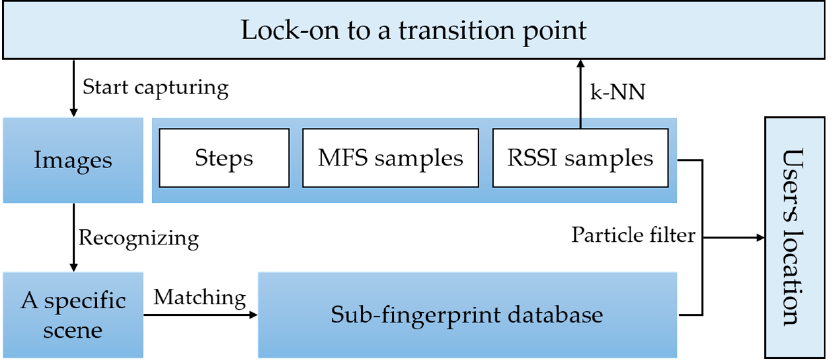
Figure 8. Procedures of localization estimation. Lock-on to a transition point is needed when the localization start. The detection of transition point utilize a k-NN algorithm.